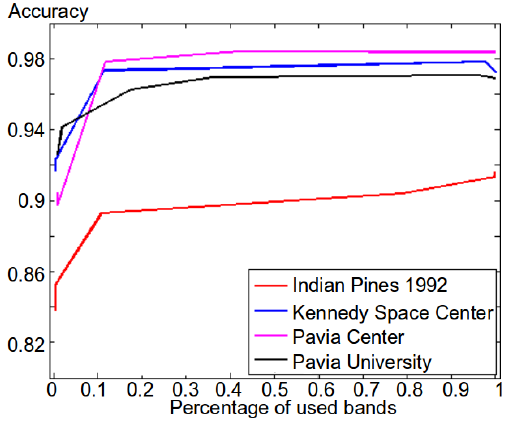
Figure 8: Classification accuracy versus (relative) number of bands